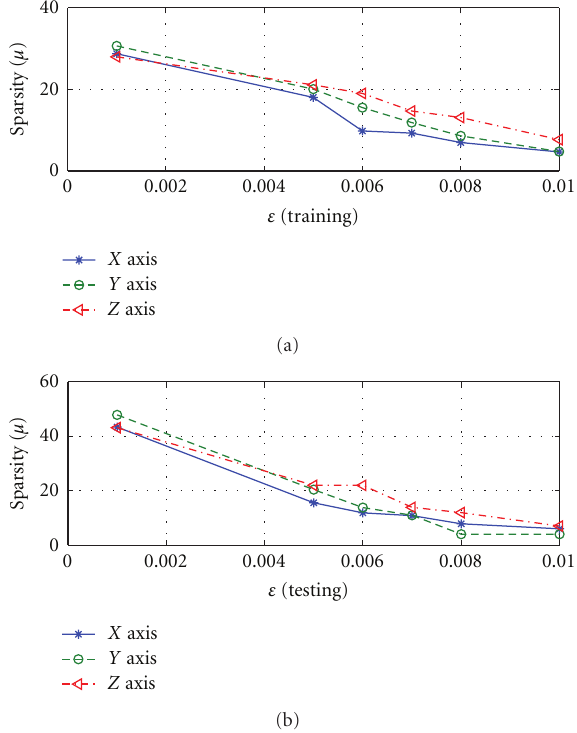
Figure 7: EOF of brain, gallbladder, and bladder reconstruction with SHD and SRDS methods. The left pair is for training set; the right pair is for testing set.